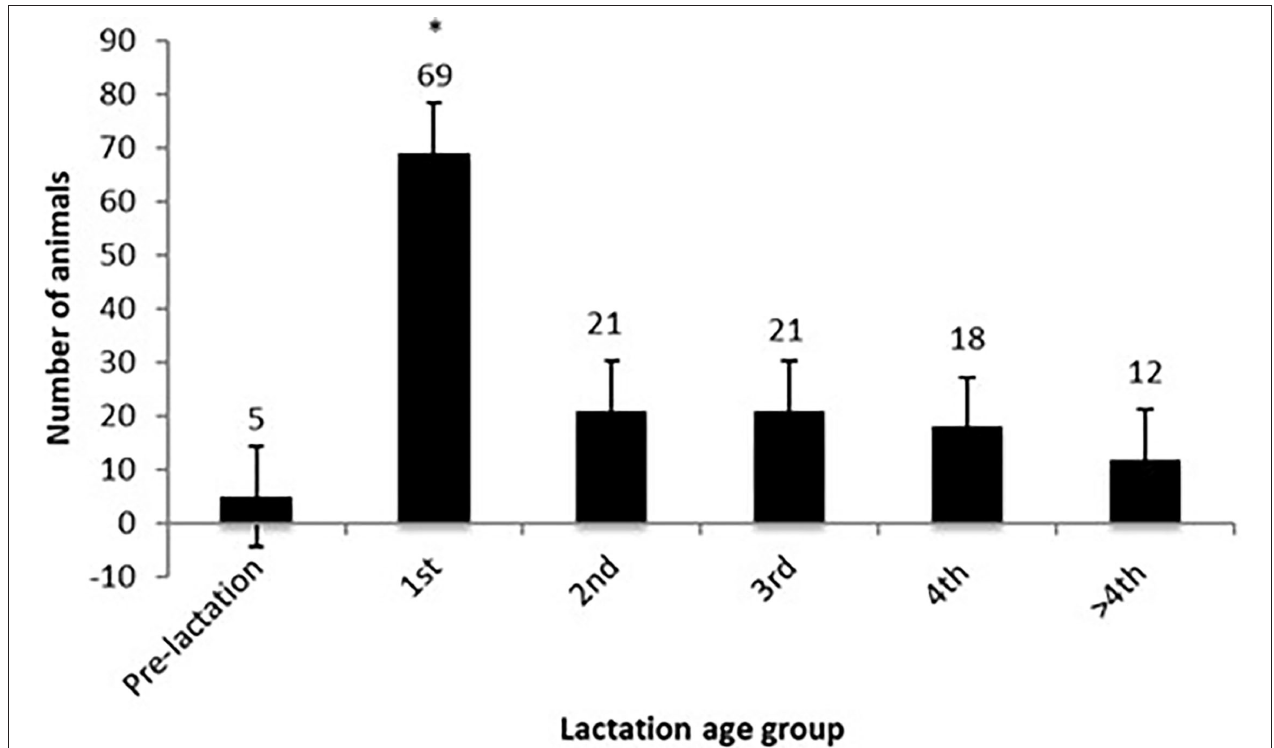
FIGURE 2 | The production age of animals depending on the lactation the cow presented with an ischaemic teat necrosis (ITN) lesion on the teat. First lactation heifers are significantly over-reported as developing ITN lesions on their teats. *Represents a significant difference ( p < 0.001).